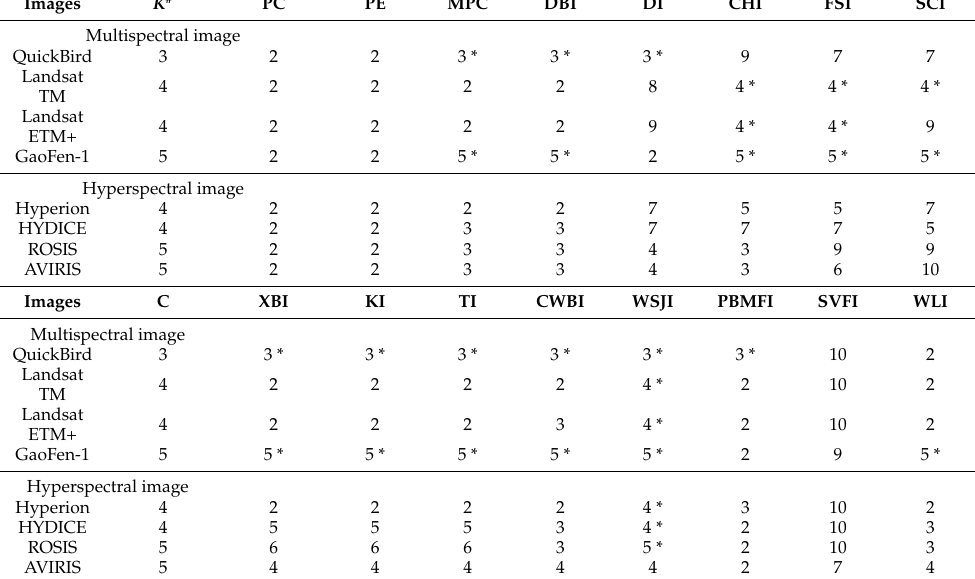
Table 13. The optimal cluster numbers indicated by the CVIs by K-means for each remote sensing